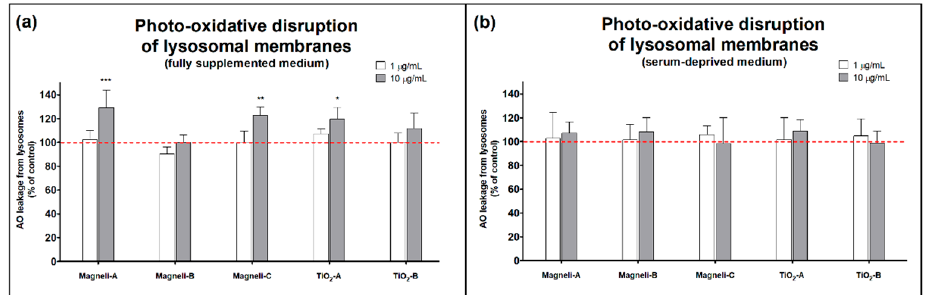
Figure 3. Destabilization of lysosomal membranes in nanoparticle exposed A549 cells, measured by Acridine orange (AO) leakage from lysosomes after UV-A irradiation in ( a ) fully supplemented cell medium and in ( b ) serum-deprived cell medium. For each treatment condition, at least three independent experimental repeats, each with five replicates, were performed. Results are presented as an average AO leakage (+SD) from lysosomes according to nanoparticle untreated, but UV-A irradiated controls (dashed line). An asterisk represents a significant difference with respect to the untreated control cells (* equals p < 0.05; ** equals p < 0.01; *** equals p < 0.001; ANOVA with Bonferroni’s post test).